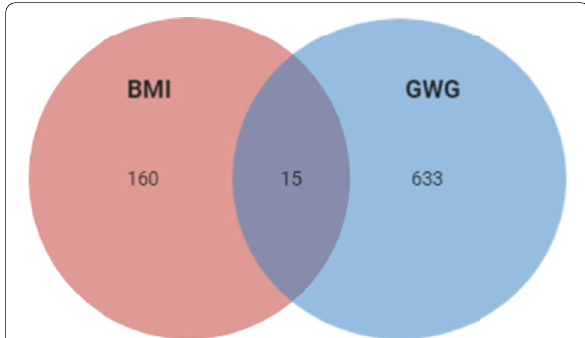
Fig. 2 Venn diagram of the association of imputed gene expression which influence BMI in the Giant cohort, GWG in T1DM cohort, and both phenotypes